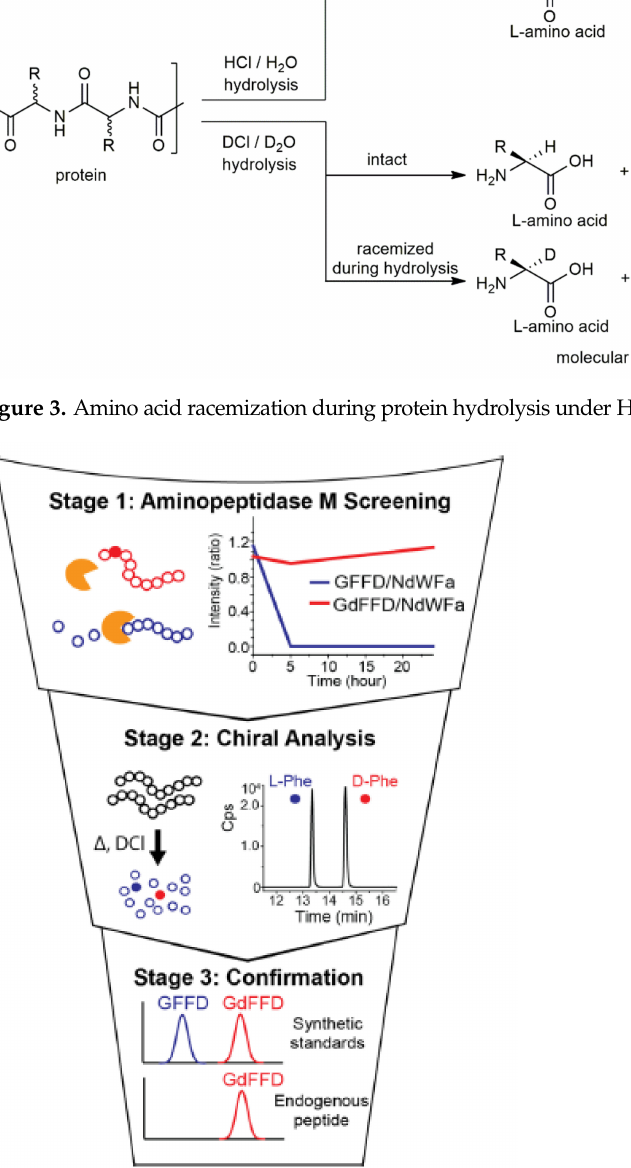
Figure 4. DAACP discovery funnel is capable of identifying DAACPs in three stages, as illustrated with GdFFD. In stage 1, MS-based detection of APM digestion is capable of identifying potential DAACPs in the screening phase of the discovery funnel. Here, GFFD, used as an example, is rapidly degraded after 5 h, whereas its DAACP counterpart, GdFFD, is not degraded after 24 h. Both are shown as a ratio to NdWF amide, a peptide that is known to resist degradation by APM. In stage 2, chiral analysis utilizes the MRM mode of MS to detect L - and D -amino acids in a peptide following acid hydrolysis and labeling. First, microwave-assisted vapor phase hydrolysis is carried out in DCl to break down peptides into their component amino acids. Importantly, DCl-based acid hydrolysis reduces detection of racemized residues in peptides. The amino acids are then labeled with Marfey’s reagent, separated and detected using a triple quadrupole mass spectrometer. The result of this step is outlined using GdFFD, where a D -Phe is detected. In stage 3, confirmation of DAACPs, peptides are synthesized with the suspected chirality at each position and then compared to the endogenous peptides. Here, the retention time of the endogenous peptide matches that of the GdFFD synthetic standard, confirming its presence as a DAACP. Reproduced with permission from the authors of